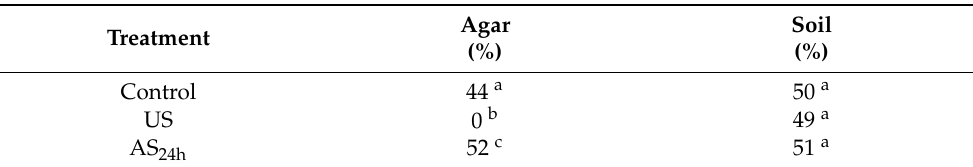
Table 3. Percentage of seed germination. Control ((NH 4 ) 2 SO 4 ), untreated (US) and aerated (AS) slurry. Data are means ( n = 3) ± SE. Agar Soil Treatment (%) (%) Control 44 a 50 a US 0 b 49 a AS 24h 52 c 51